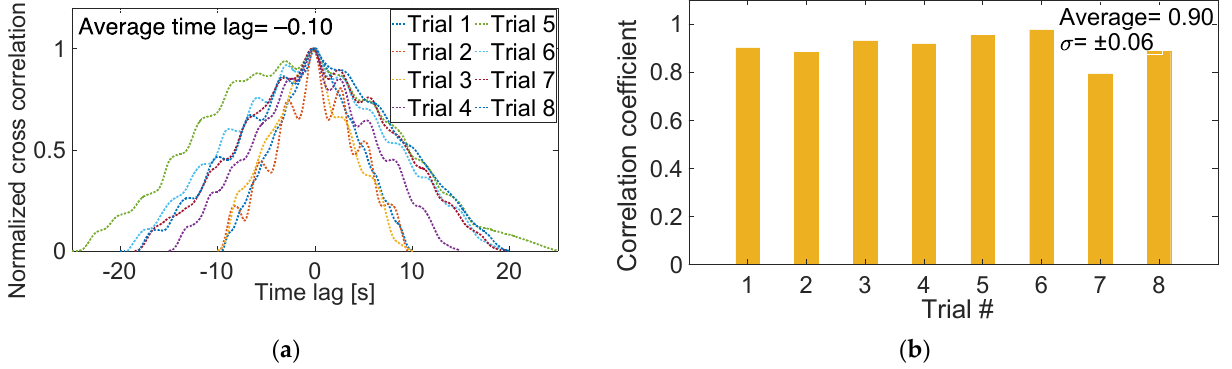
Figure 10. ( a ) The normalized cross-correlation between Motion Tape and motion capture estimated strains confirmed a low time lag. ( b ) The subject tests were repeated in eight trials, and all the results suggested a strong linear skin-strain sensing response.